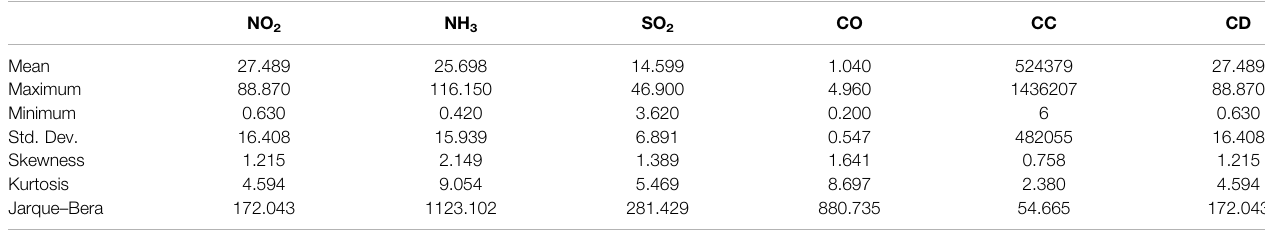
TABLE 1 | Descriptive statistics.